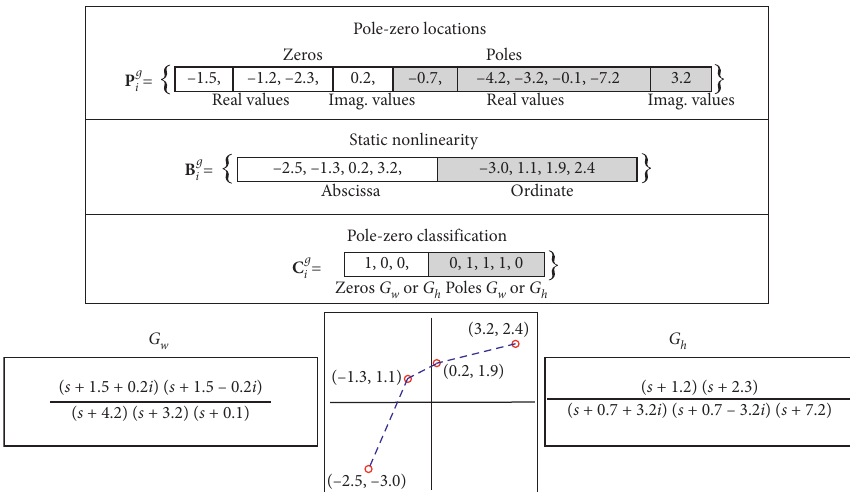
Figure 8: Example of an encoded individual and the resulting nonlinear